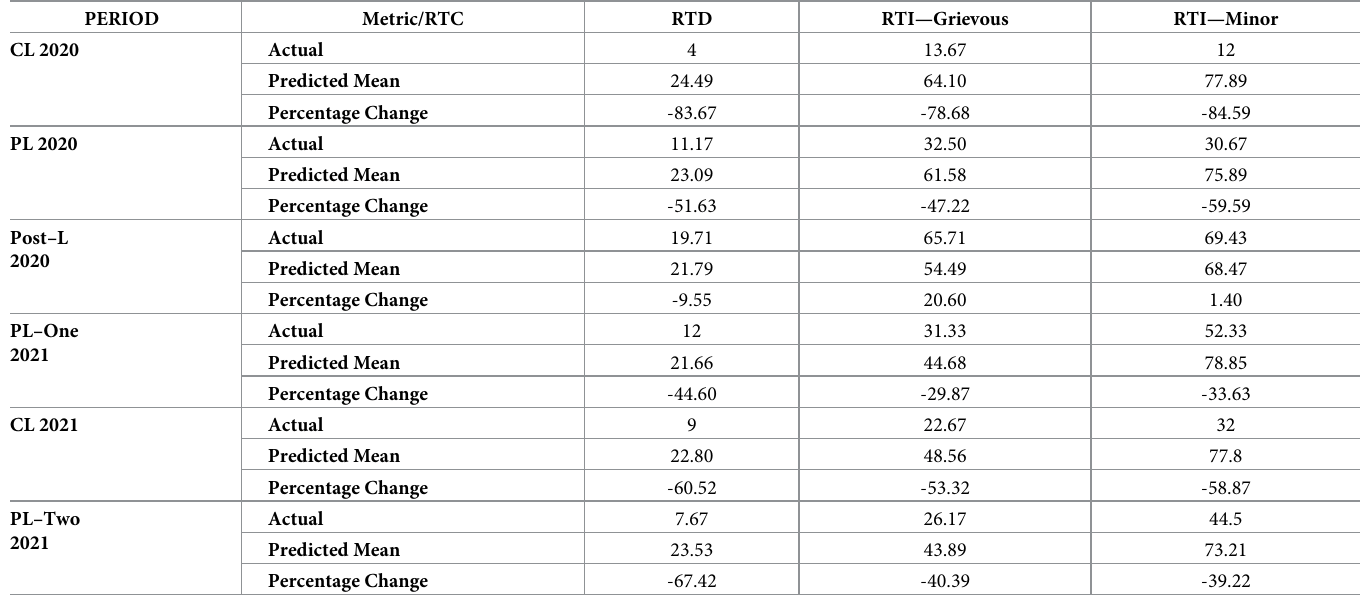
Table 6. Showing the actual and predicted daily counts of RTD/RTIs in all phases during both waves for Chennai.